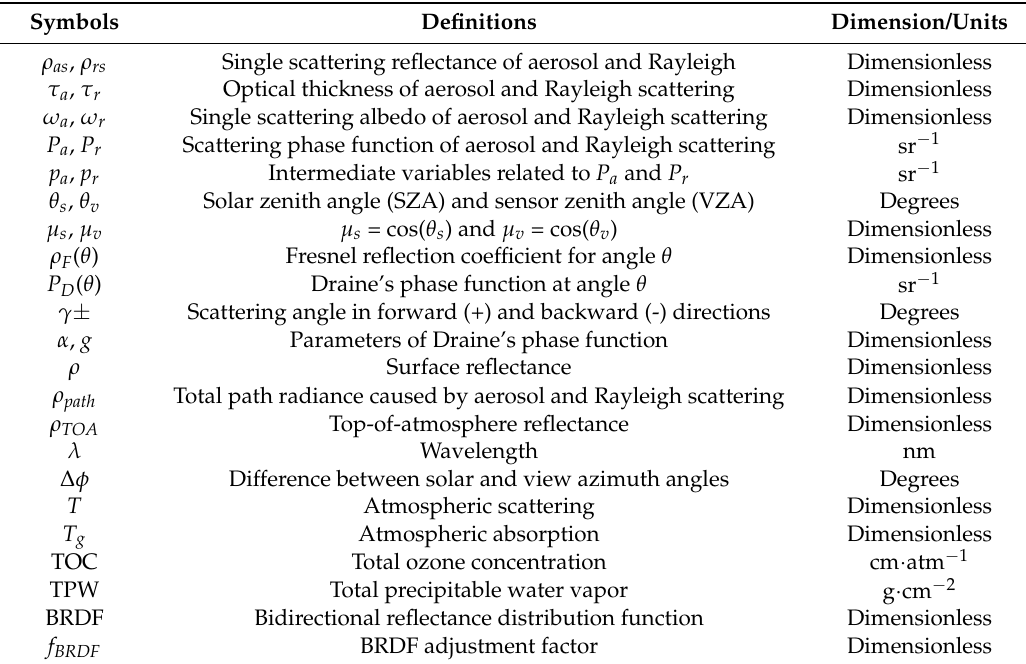
Table 1. Symbols and